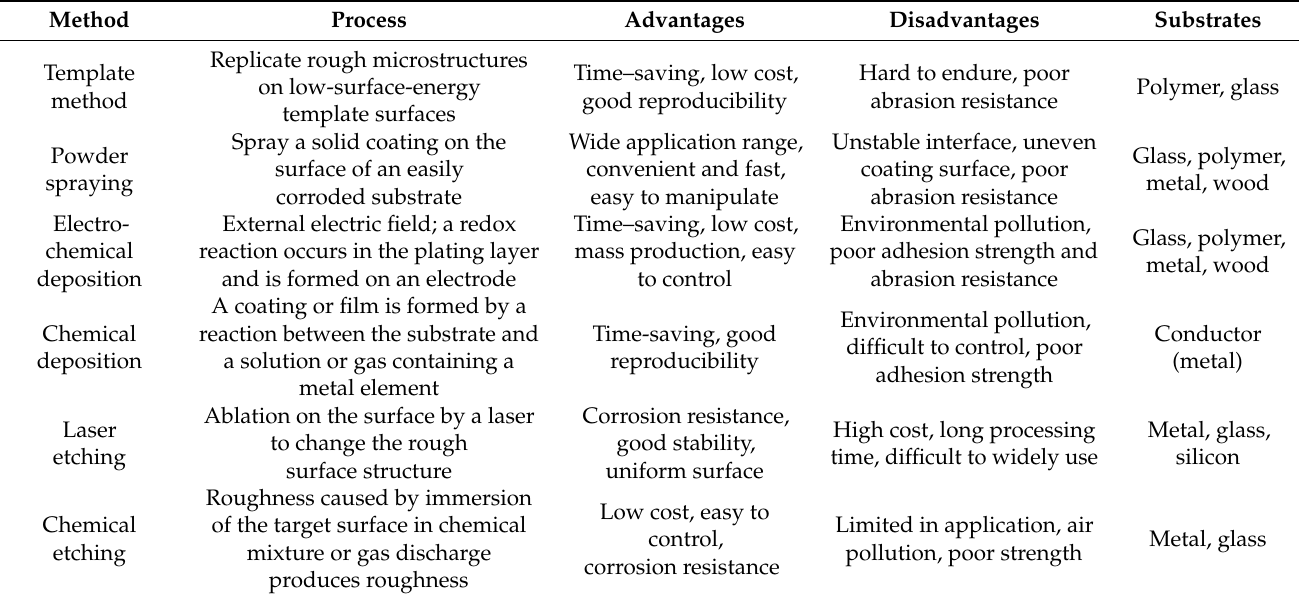
Table 1. Summary of preparation methods for superhydrophobic